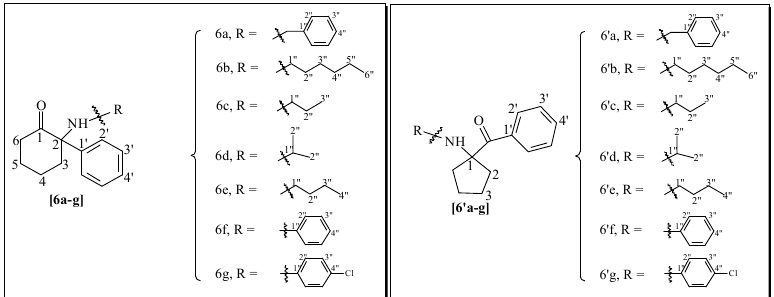
Table 5. Numbering system for NMR chemical shift attribution of library compounds 6a–g , 6  a–g